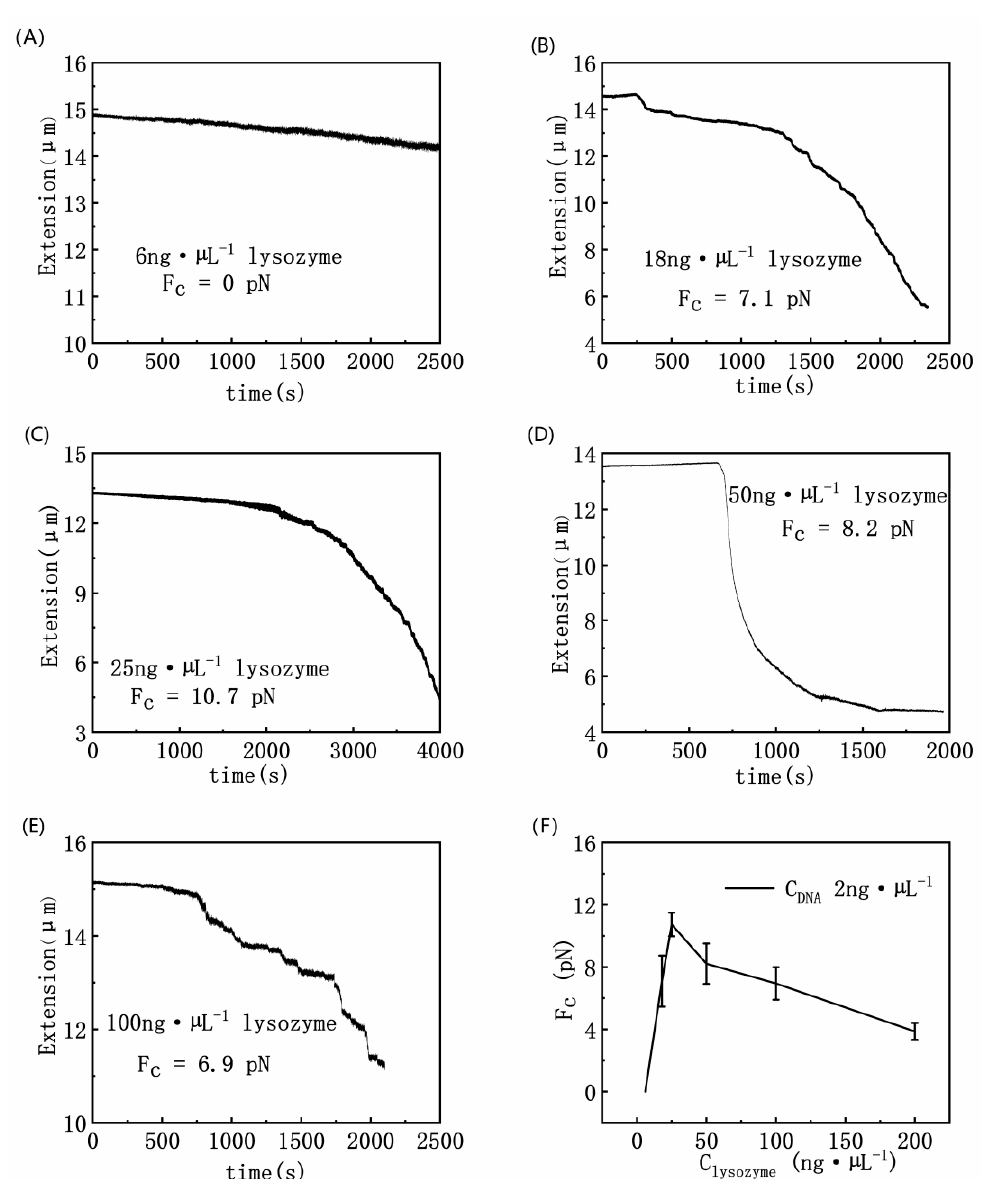
Figure 2. DNA contraction curve as a function of time at different lysozyme concentrations (( A ) 6 ng · µ L − 1 lysozyme; ( B ) 18 ng · µ L − 1 lysozyme; ( C ) 25 ng · µ L − 1 lysozyme; ( D ) 50 ng · µ L − 1 lysozyme; ( E ) 100 ng · µ L − 1 lysozyme; ( F ) DNA condensing force of DNA–lysozyme complexes as a function of lysozyme concentrations of solutions (F: 6 ng · µ L − 1 ,18 ng · µ L − 1 ; 25 ng · µ L − 1 , 50 ng · µ L − 1 , 100 ng · µ L − 1 , 200 ng · µ L − 1 ).